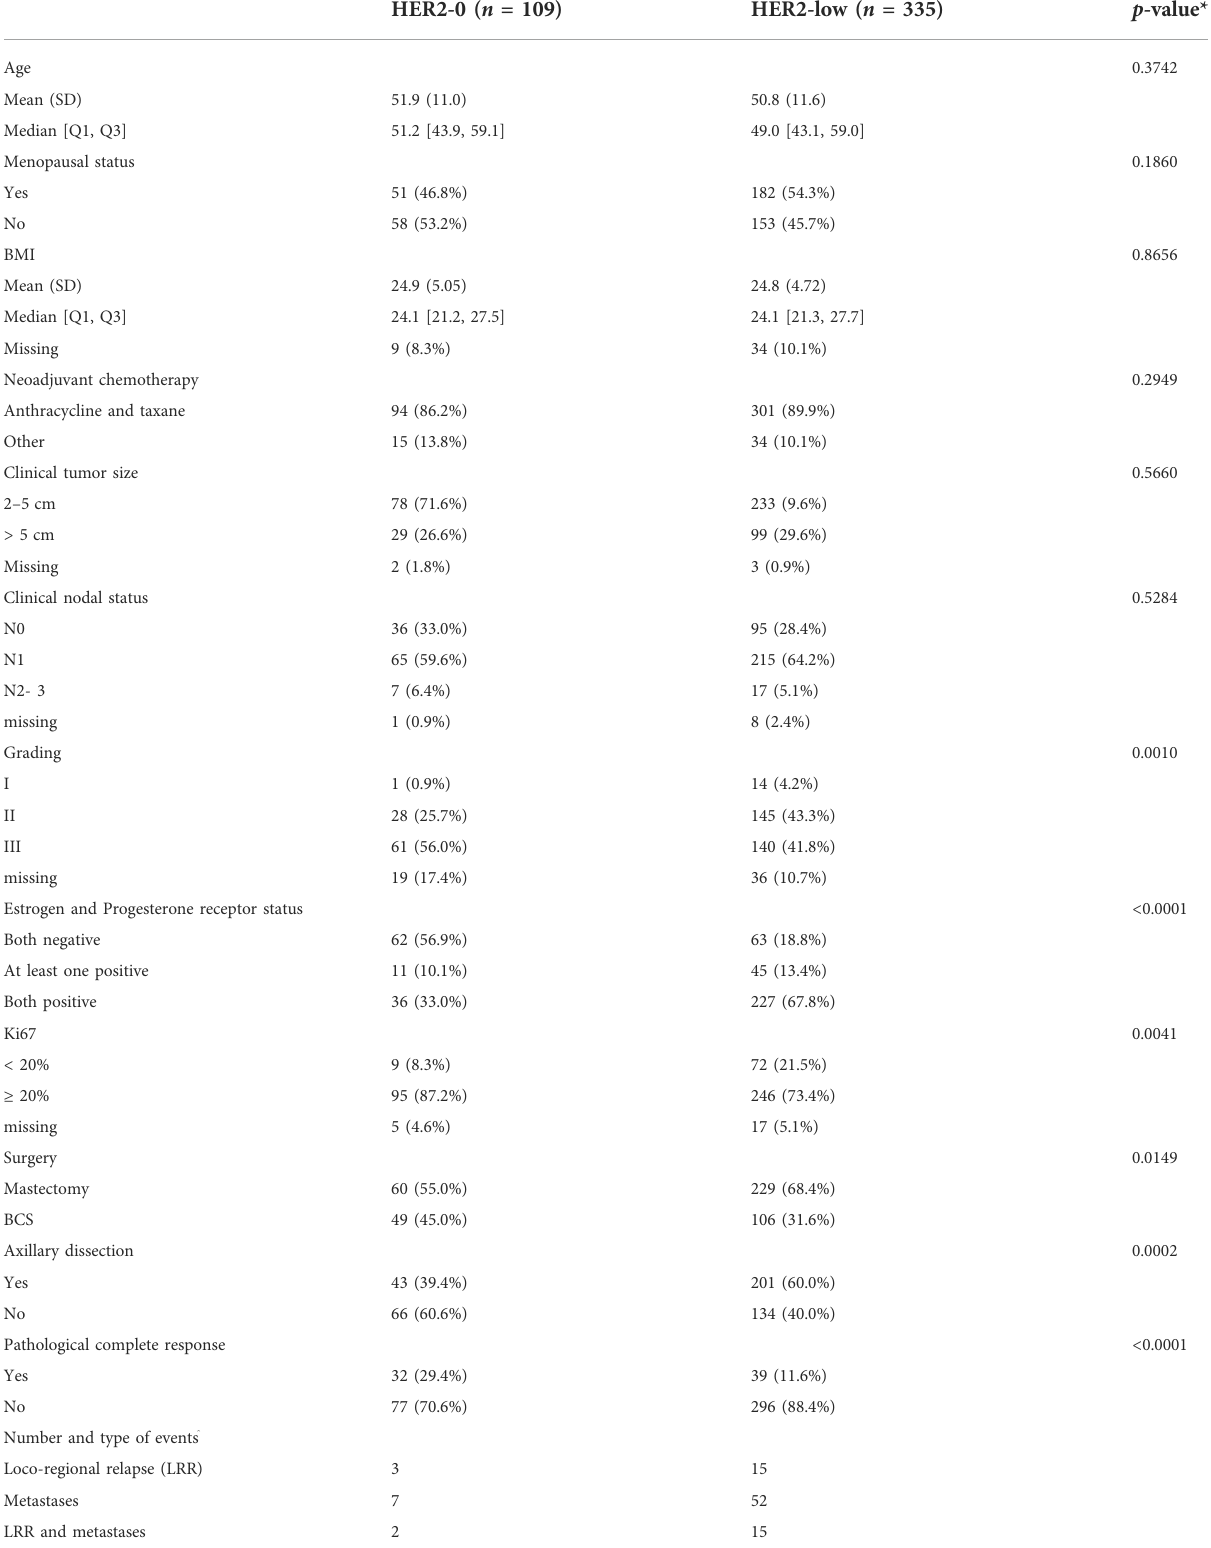
TABLE 1 Baseline patient and primary tumor characteristics according to HER2-0 and HER2-low status.